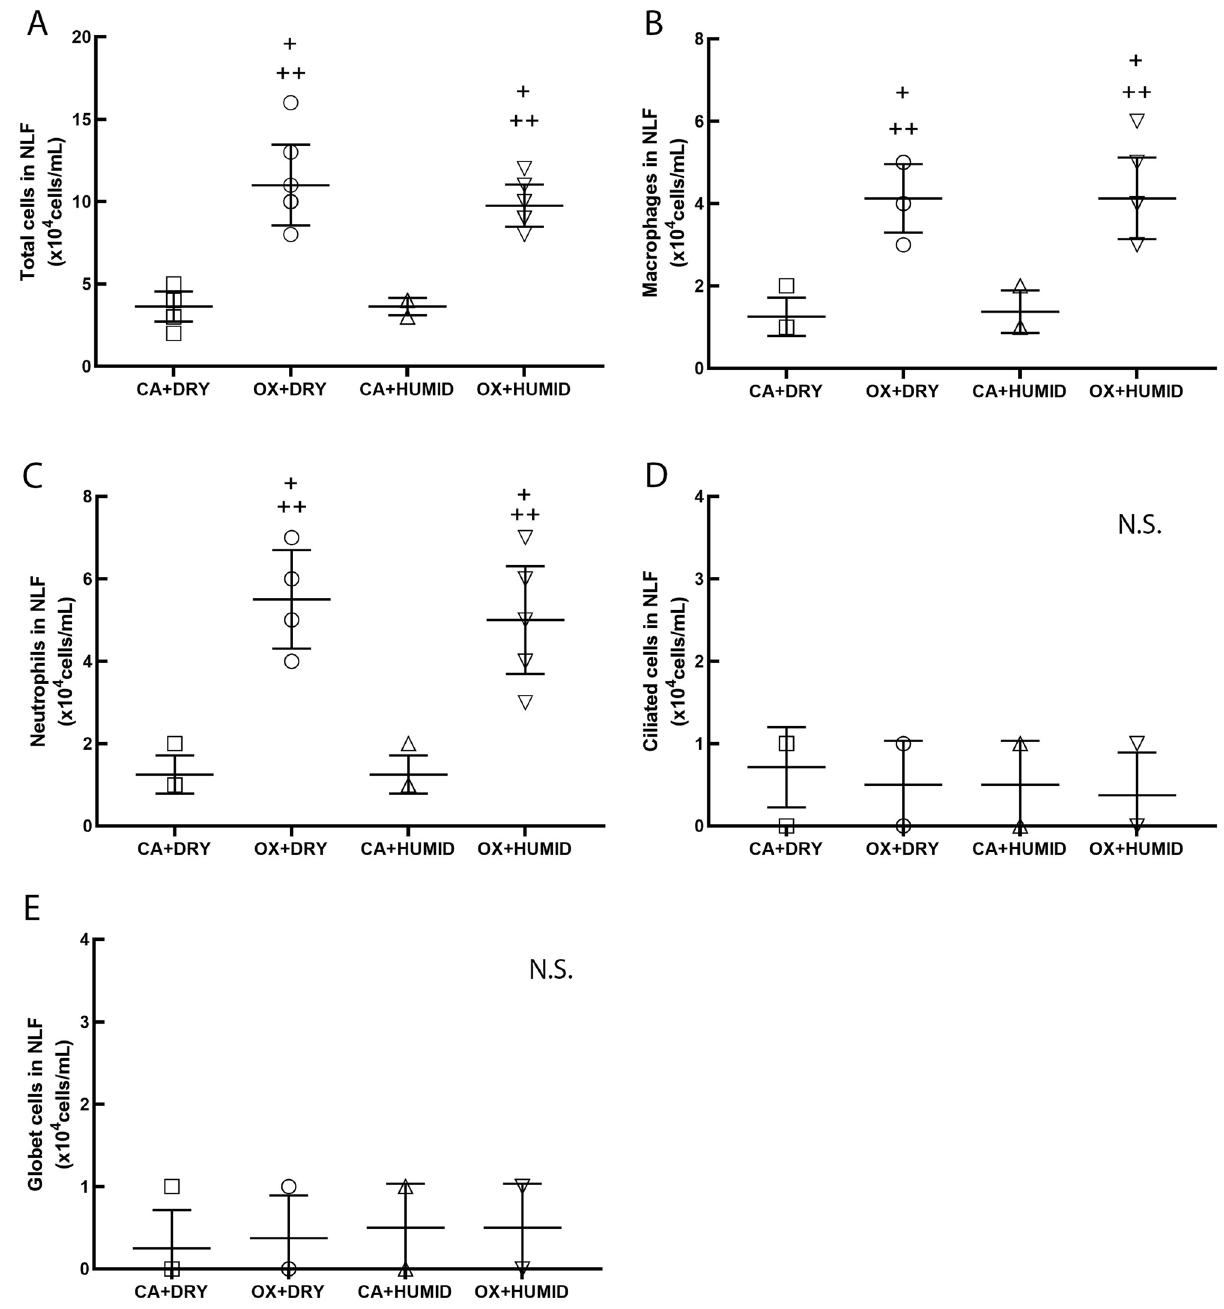
Figure 4. Nasal lavage fluid—total cells ( A ), macrophages ( B ), neutrophils ( C ), ciliated cells ( D ) and goblet cells ( E ). + P < 0.05 compared to CA + DRY group. ++ P < 0.05 compared to CA + HUMID